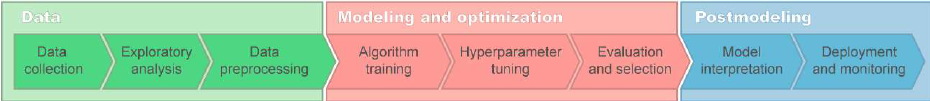
Figure 9. Usual machine learning workflow.